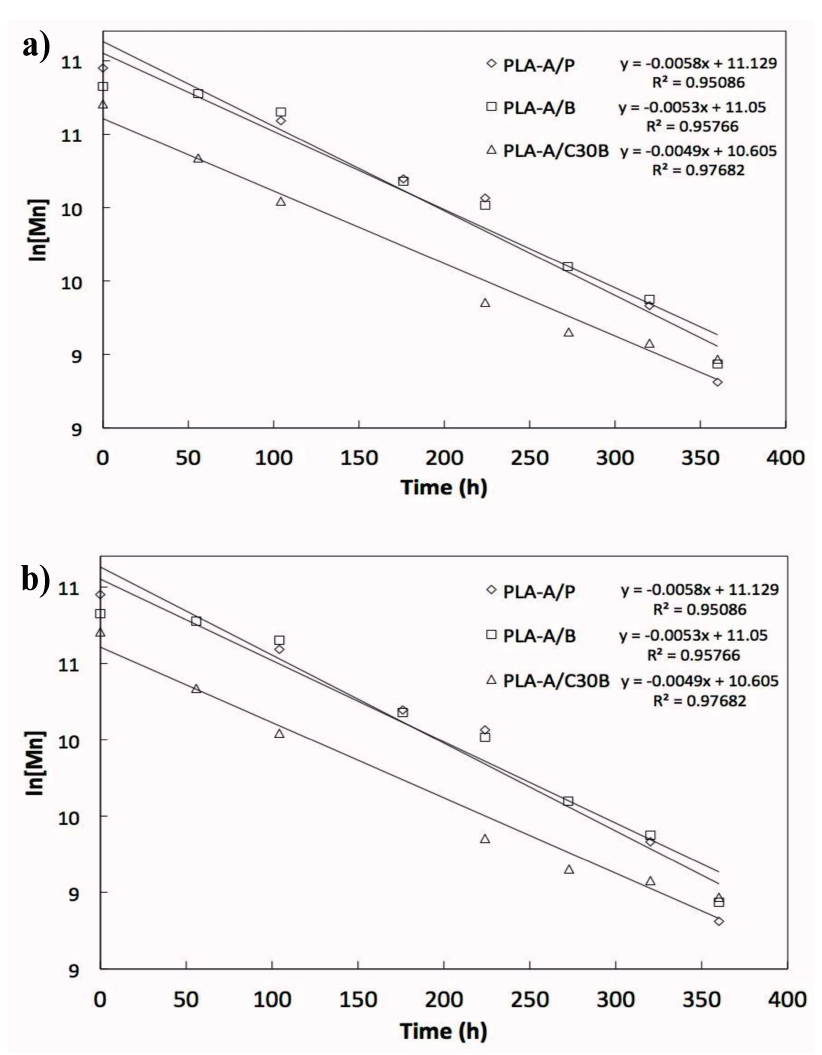
Figure 7. First order decay of ( a ) amorphous and ( b ) semicrystalline PLA molecular